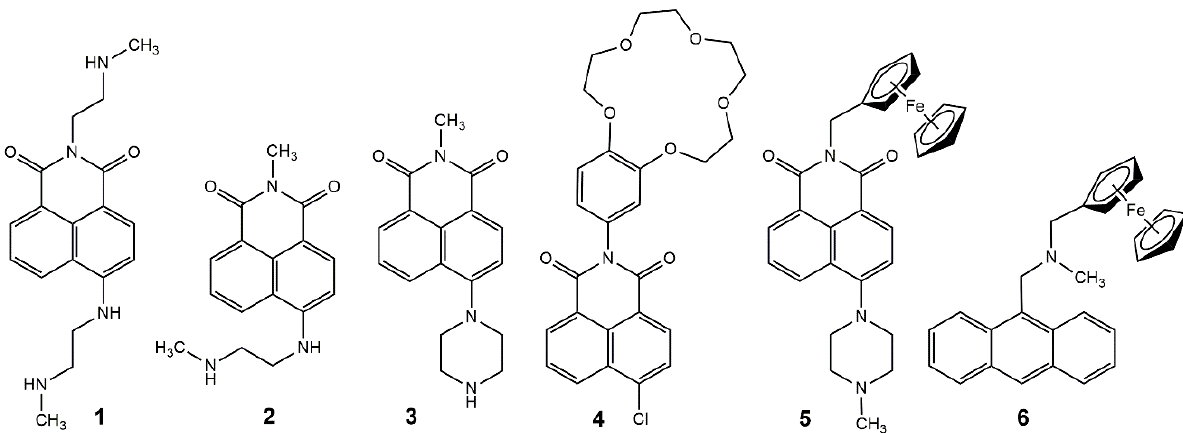
Figure 2. The molecules studied in cross-linked polyacrylamide hydrogels.